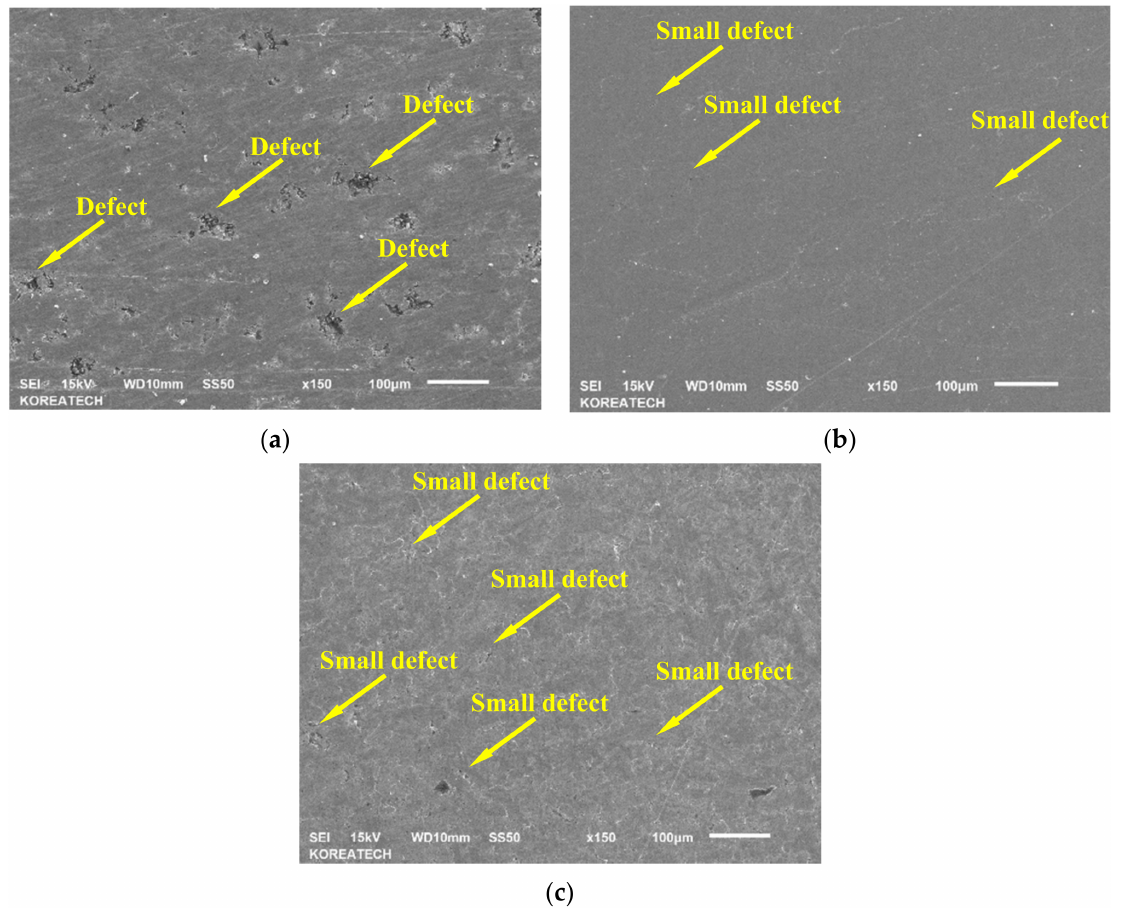
Figure 5. Comparison in surface morphology of the untreated ( a ), UNSM-treated at RT ( b ) and UNSM-treated at HT ( c )